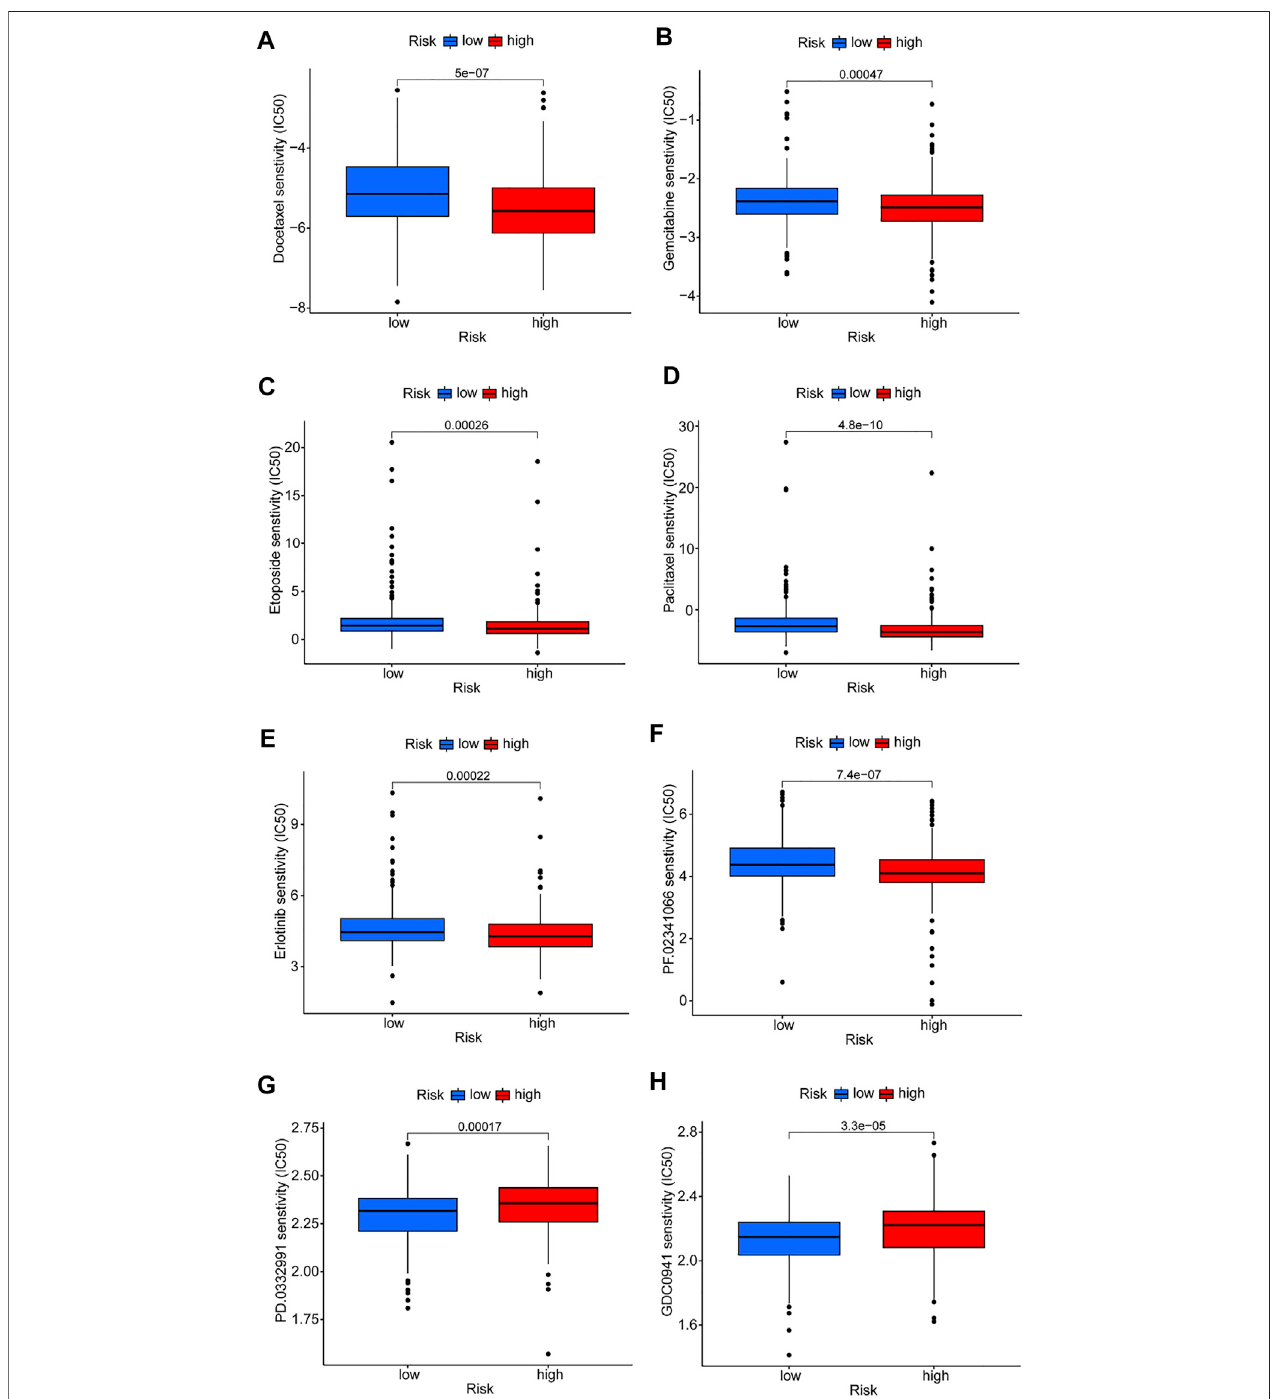
FIGURE 8 | Prediction of drug susceptibility in different risk groups. (A – F) Sensitive drugs in high-risk groups. (G,H) Sensitive drugs in low-risk groups.